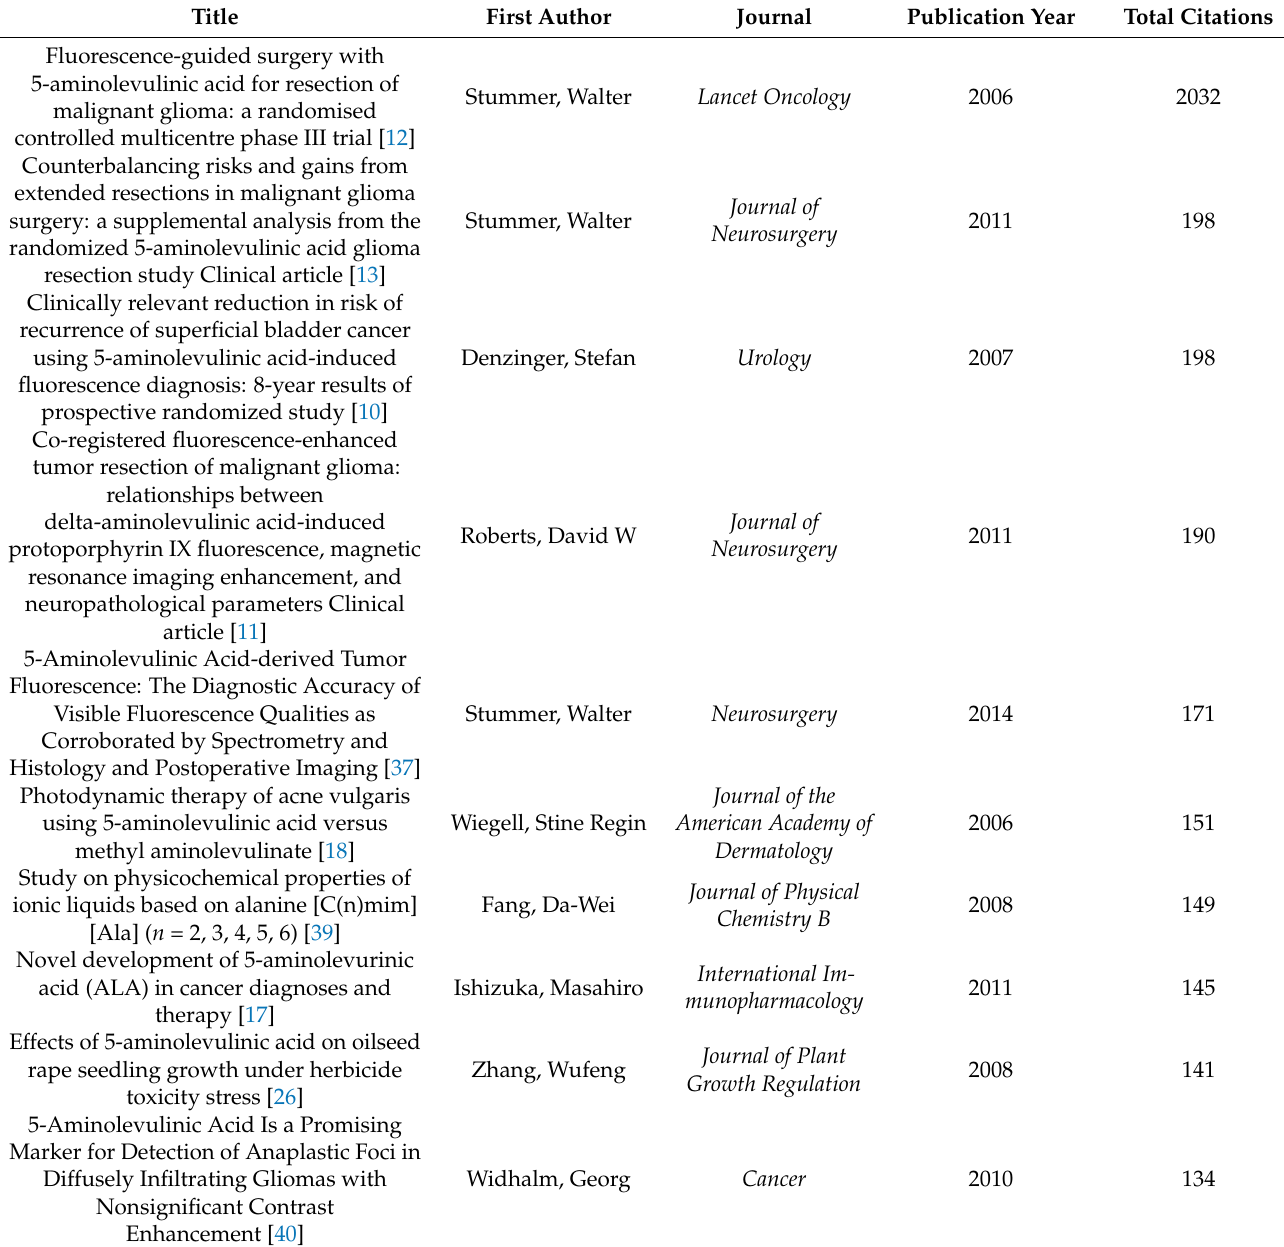
Table 3. Top-10 most cited literatures in the field of